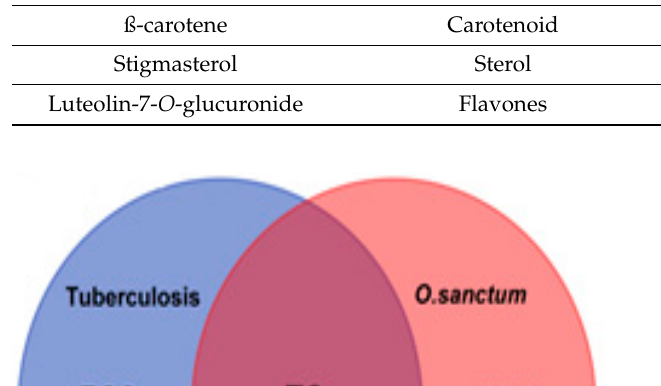
Figure 3. Venn diagram showing common targets.